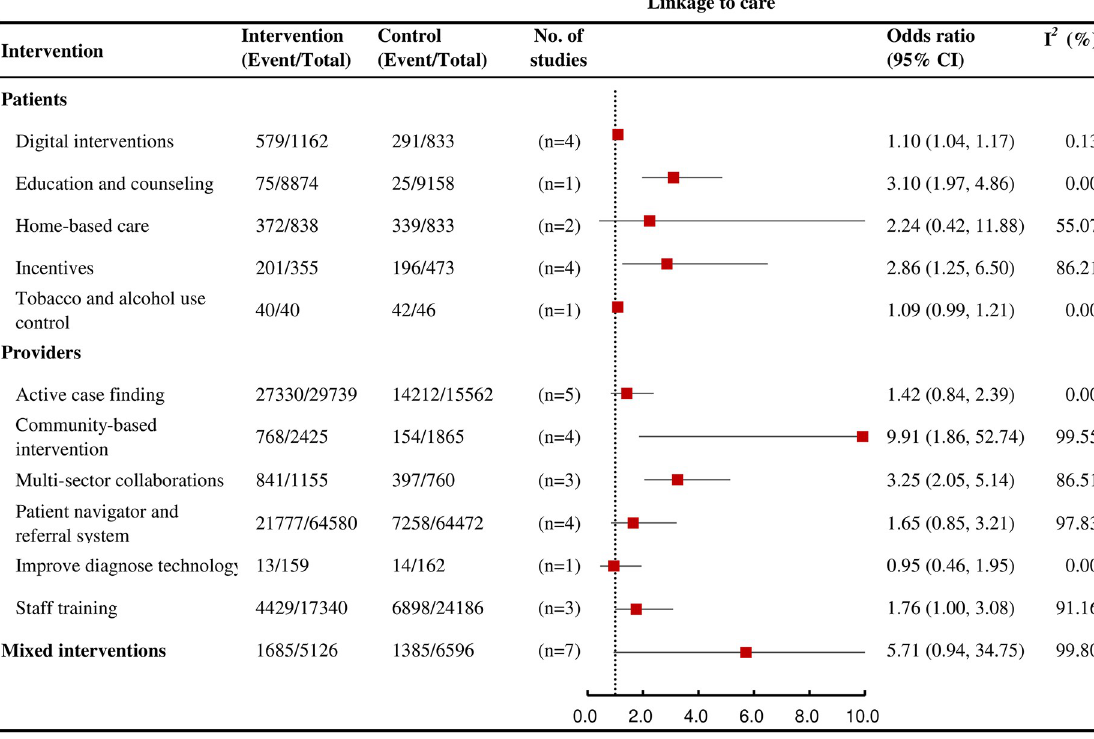
Fig 5. Forest plots showing the effects of various interventions on TB linkage to care outcomes for active TB.